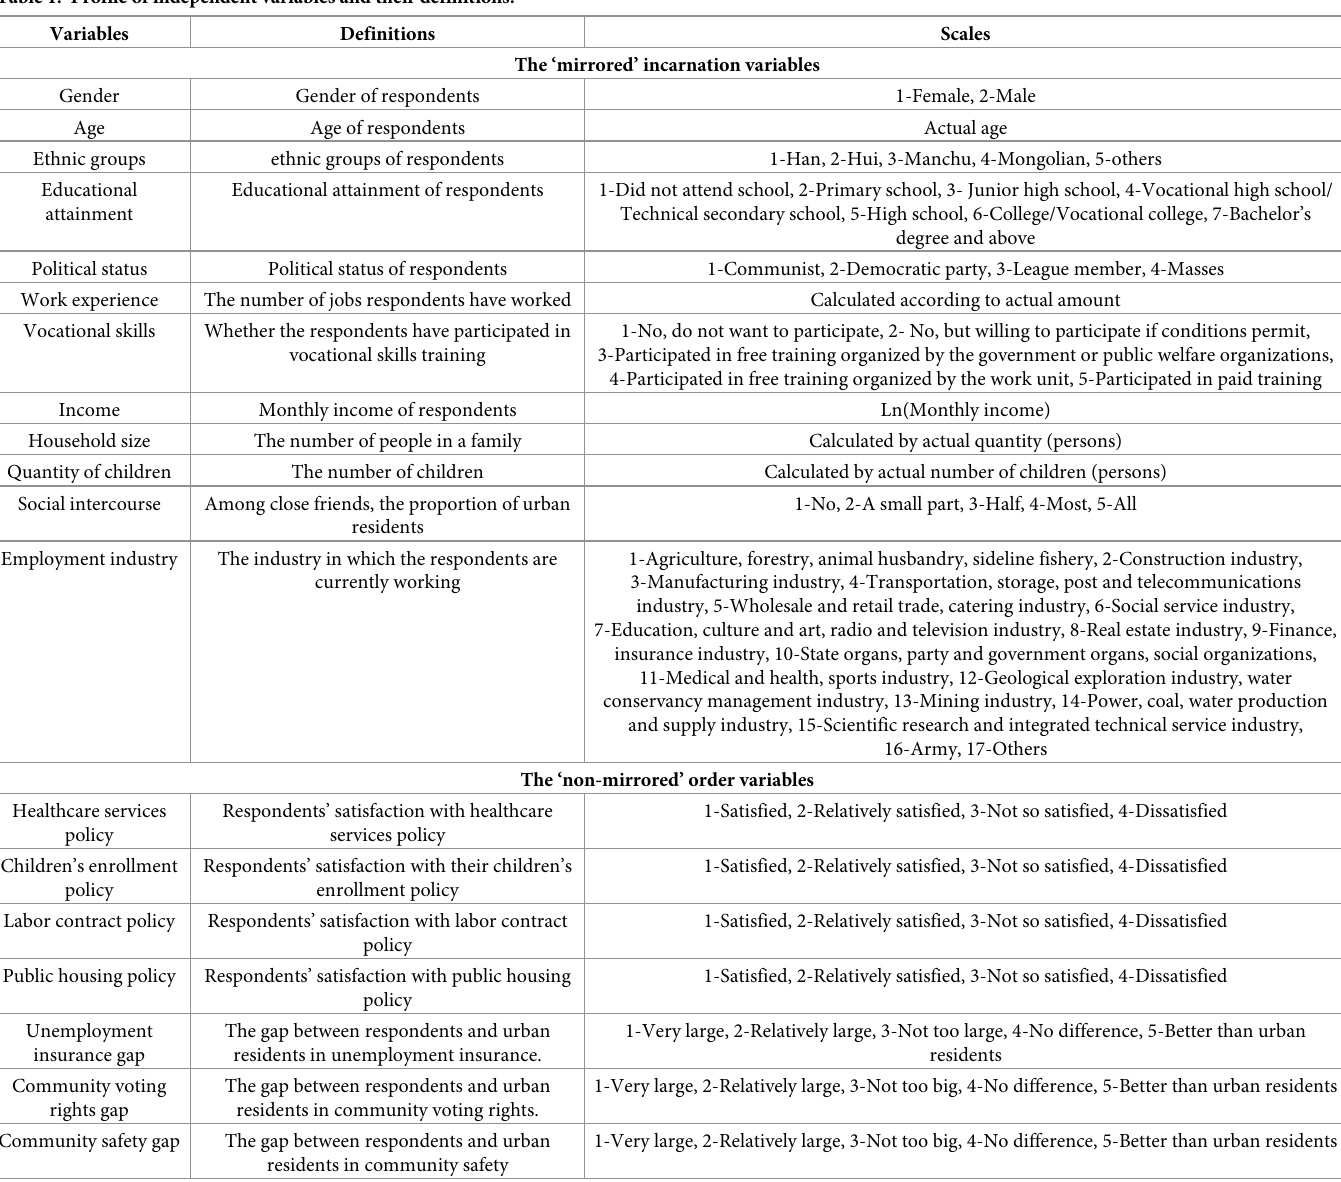
Table 1. Profile of independent variables and their